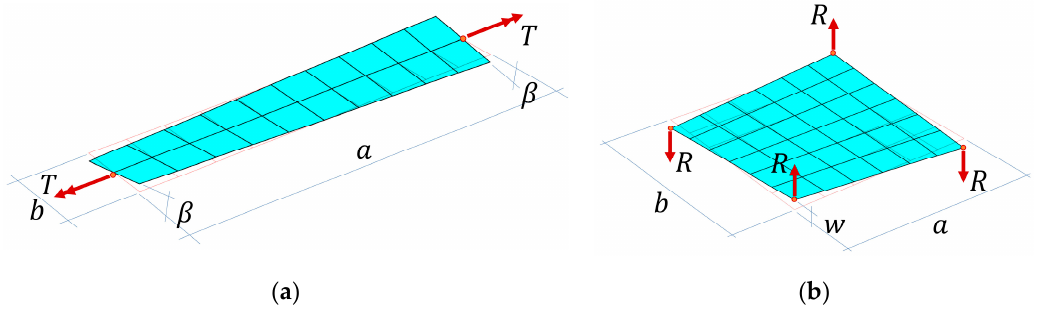
Figure 2. Two mechanical test setups to measure transversal shear stiffness of the sample: ( a ) via torque and angle of rotation and ( b ) via pair of force and vertical displacement (plate torsion test).